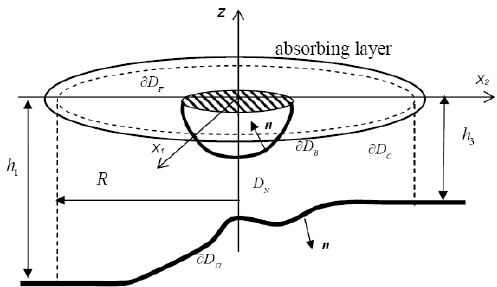
Figure 2. Formulation of diffraction and radiation problems in variable bathymetry regions.